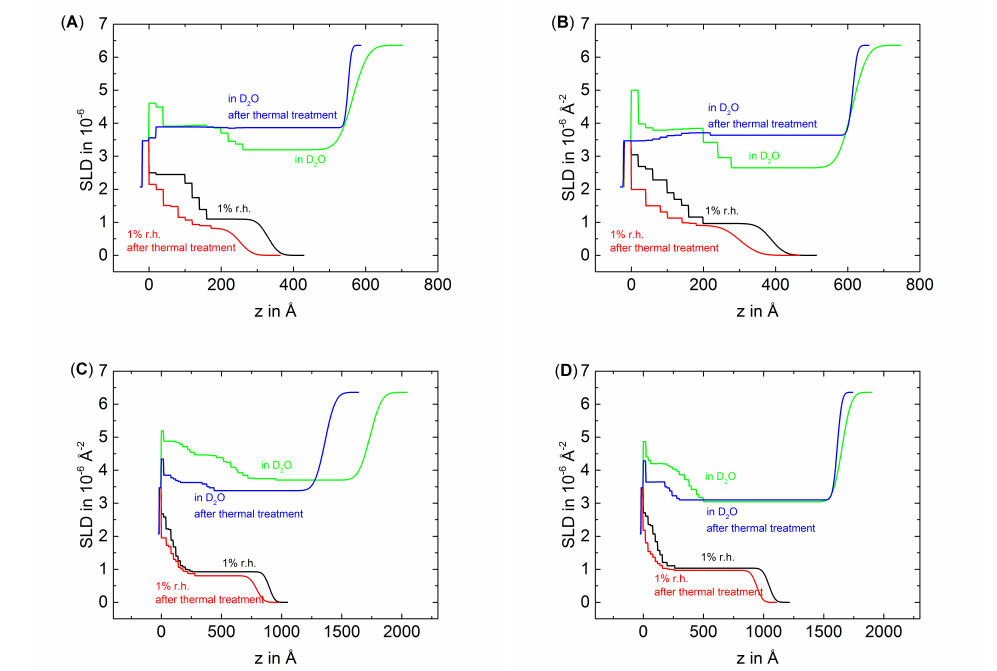
Figure 3. SLD profiles of D6H4 ( A ); D6H4.5 ( B ); D6H12 ( C ) and D6H12.5 ( D ) according to the fitted reflectivity data shown in Figure 2, whereby the SiO x /PEM interface is defined as z =